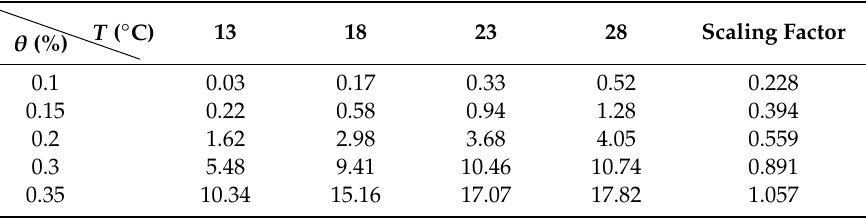
Table 5. Unsaturated hydraulic conductivity of soil under a 5 ◦ C temperature